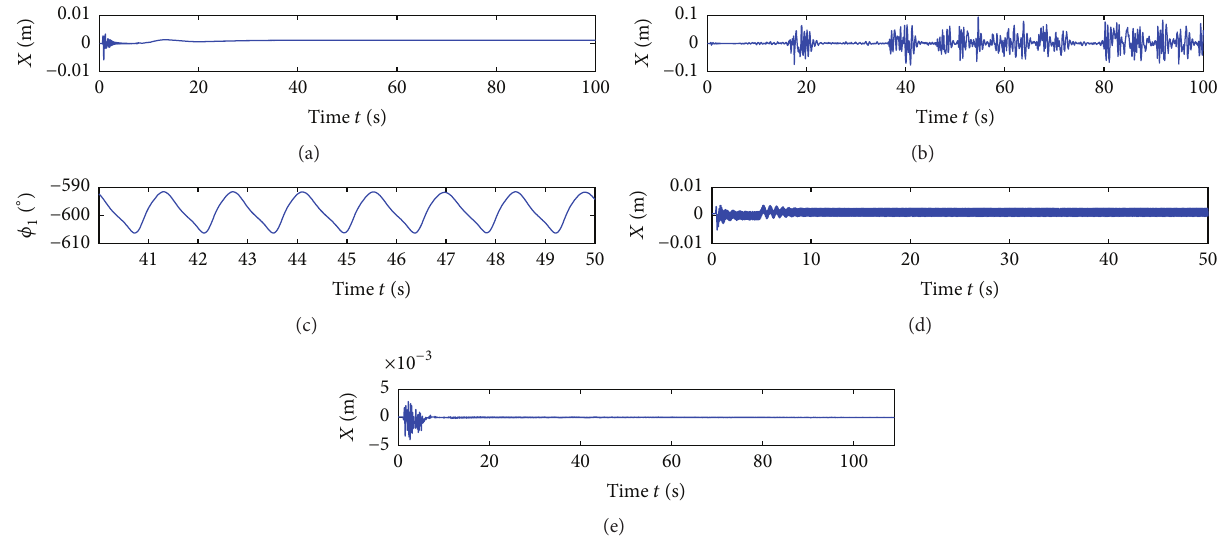
Figure 11: Validations of the tip-over speed Ω ∗ 2 when ℎ 𝑏 = 0.2 m, 𝑚 𝑏 = 0.8 kg, and Ω = 11.5 Hz (a); ℎ 𝑏 = 0.2 m, 𝑚 𝑏 = 0.8 kg, and Ω = 12.5 Hz (b); ℎ 𝑏 = 0.2 m, 𝑚 𝑏 = 1.5 kg, and Ω = 10 Hz (c); ℎ 𝑏 = 0.2 m, 𝑚 𝑏 = 0.31 kg, Ω = 30 Hz, and 𝜇 = 0.3 (d); ℎ 𝑏 = 0.1 m, 𝑚 𝑏 = 1.5 kg, and Ω = 100 Hz